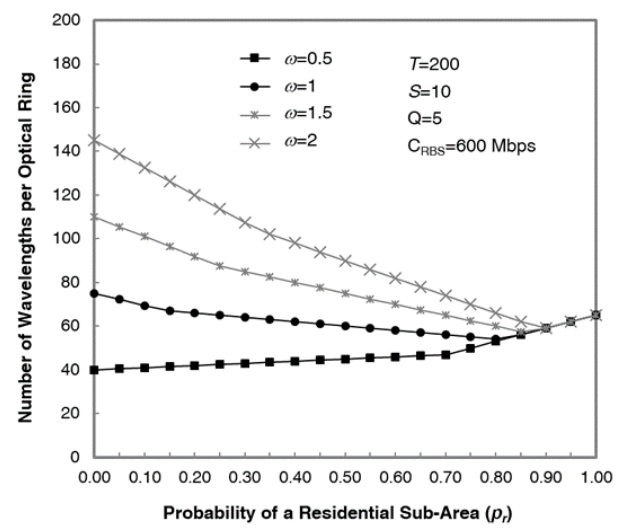
Figure 8. The number of wavelengths per optical ring is reported as a function of the probability p r of residential sub-area. The peak offered traffic A o , r for a residential sub-area is fixed equal to 16 Gbps while the ratio ω = A o , b is varied from 0.5 to 2. The percentage γ of used RRUs equals 0.6. R = 2 optical A o , r rings are considered. The values of the other parameters are chosen as the ones in Figure